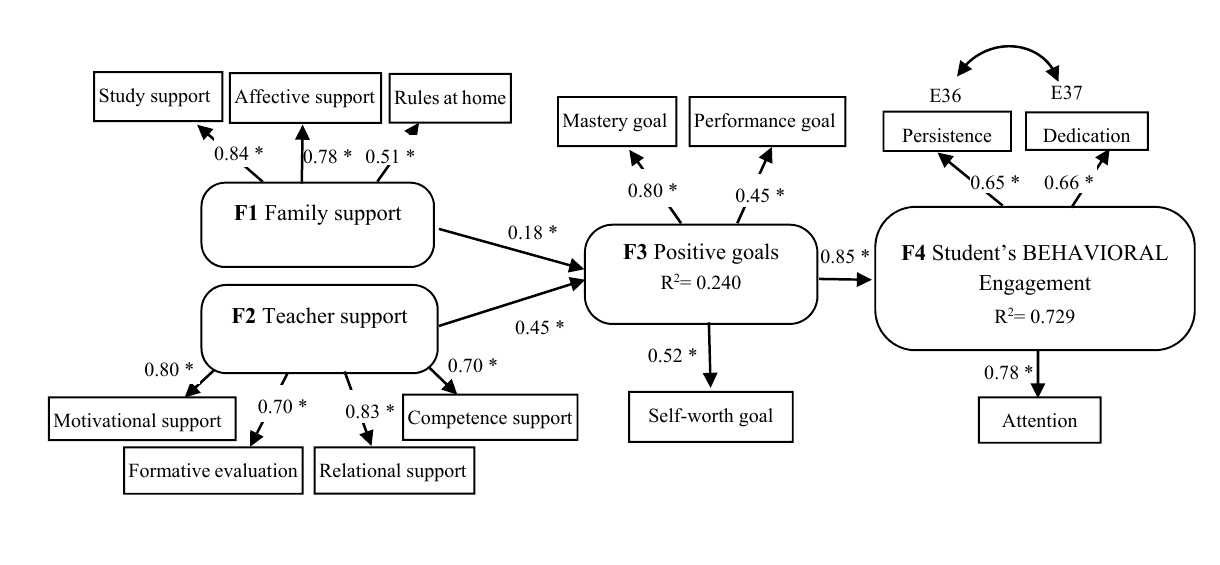
Figure 6. Optimized model (M2). Relation among teacher–family support, achievement goals, and student behavioral engagement. The structural configuration and standardized coefficients of the optimized model are displayed.